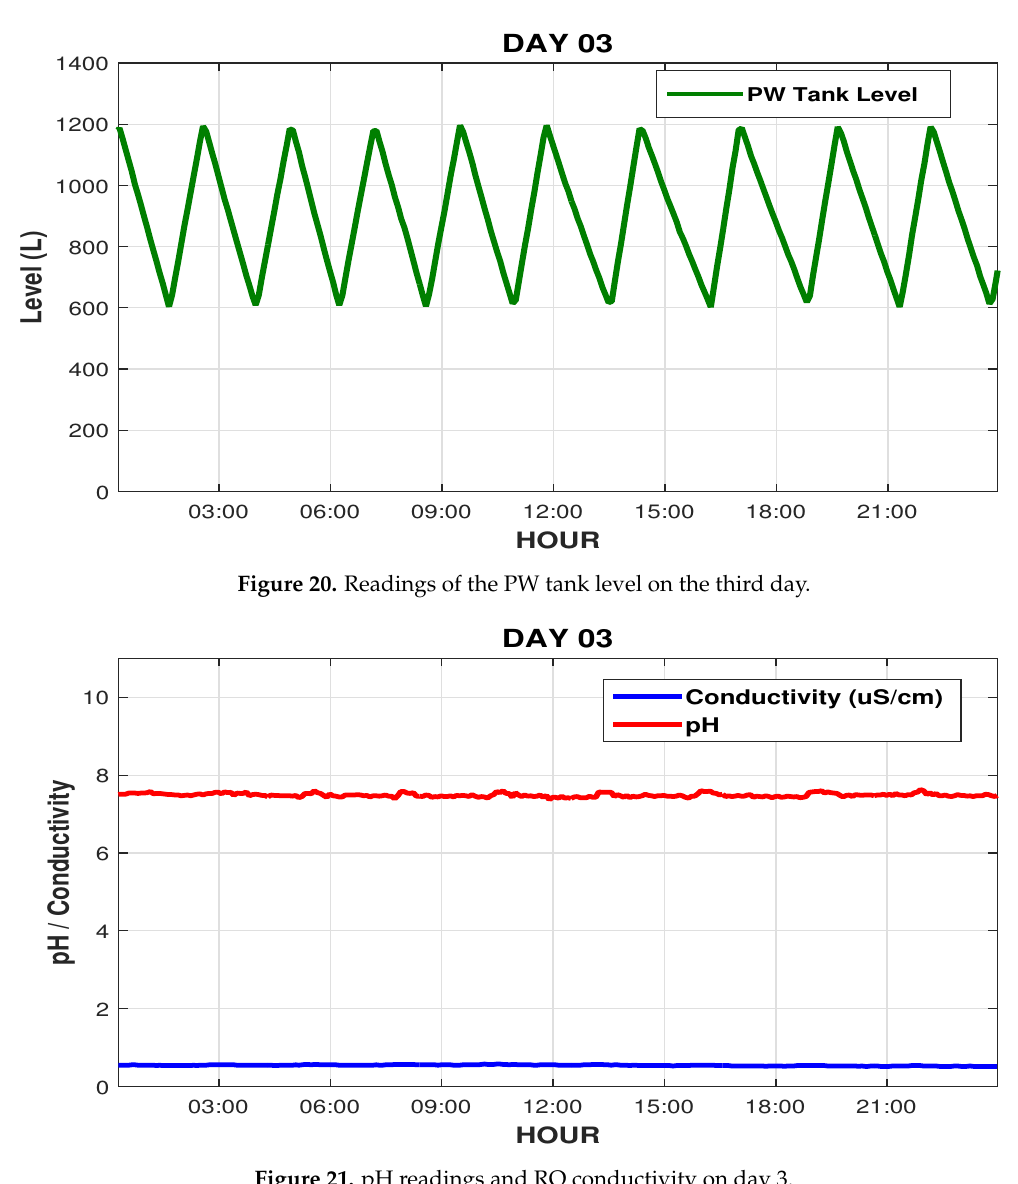
Figure 21. pH readings and RO conductivity on day